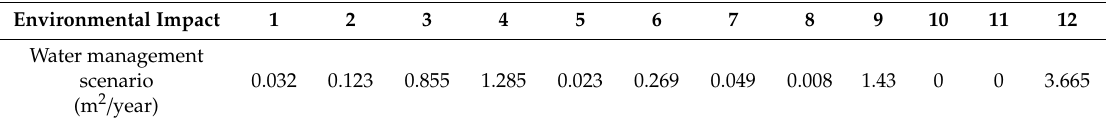
Table 7. Water management